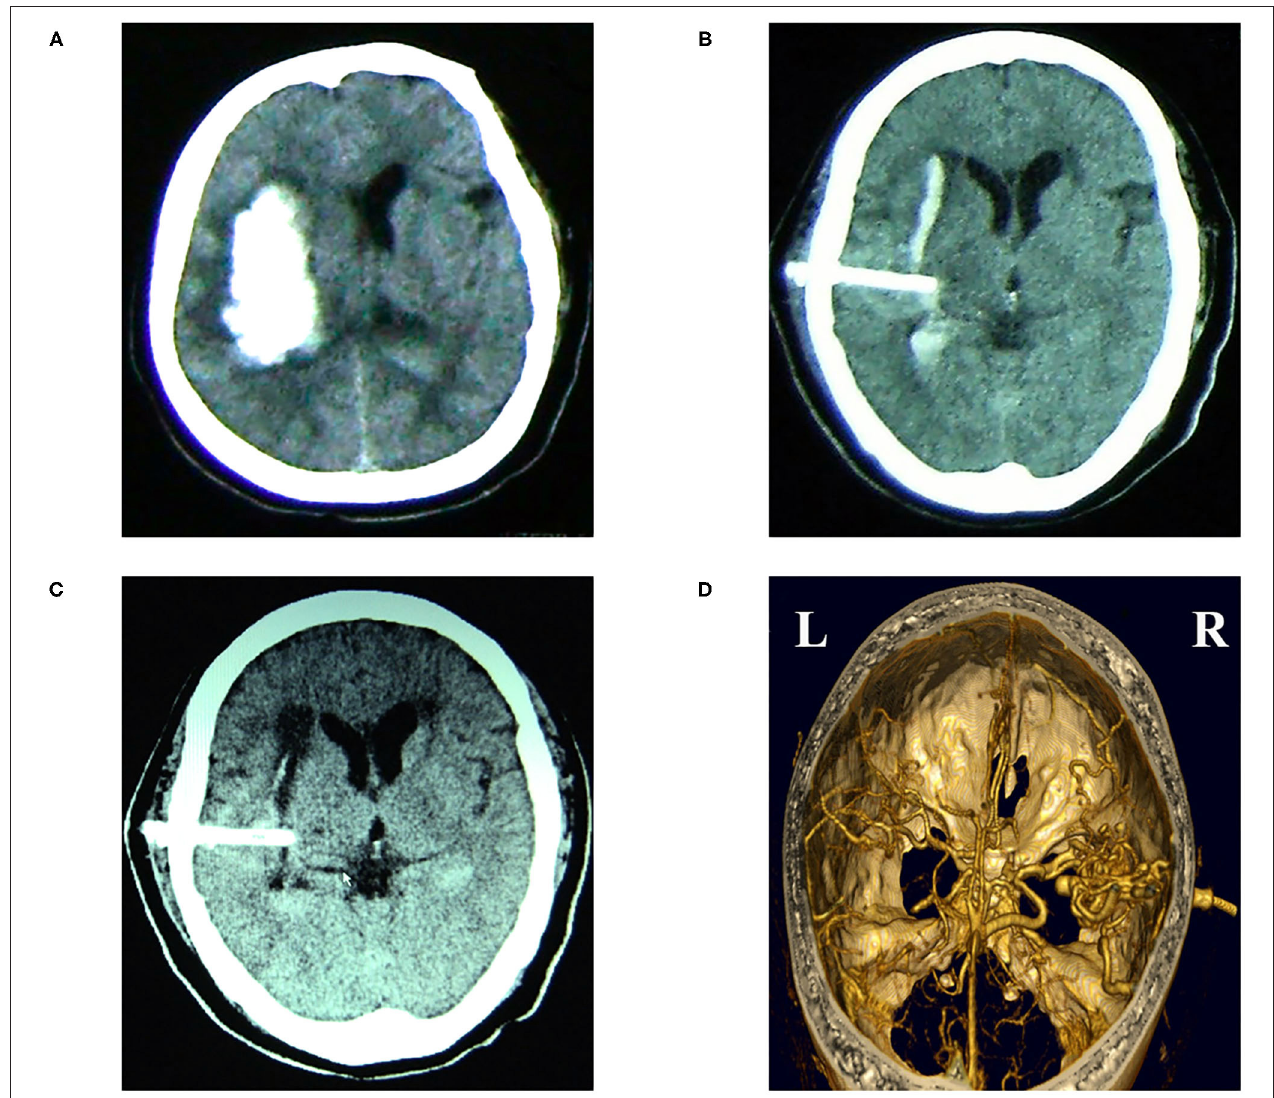
FIGURE 2 | Images from a 65-year-old patient with the hypertensive right temporal hemorrhage who received cubic oriented stereotactic aspiration. (A) Preoperative CT image of the head. (B) A post-operative CT image of the head was carried out immediately, which showed that the soft drainage tube was inserted into the hematoma and the volume of the hematoma was reduced after aspiration. (C) CT image at 4 days after operation displayed that the hematoma was almost completely evacuated. (D) The post-operative CT angiography image of the head showed that the soft tube did not lead to the damage of